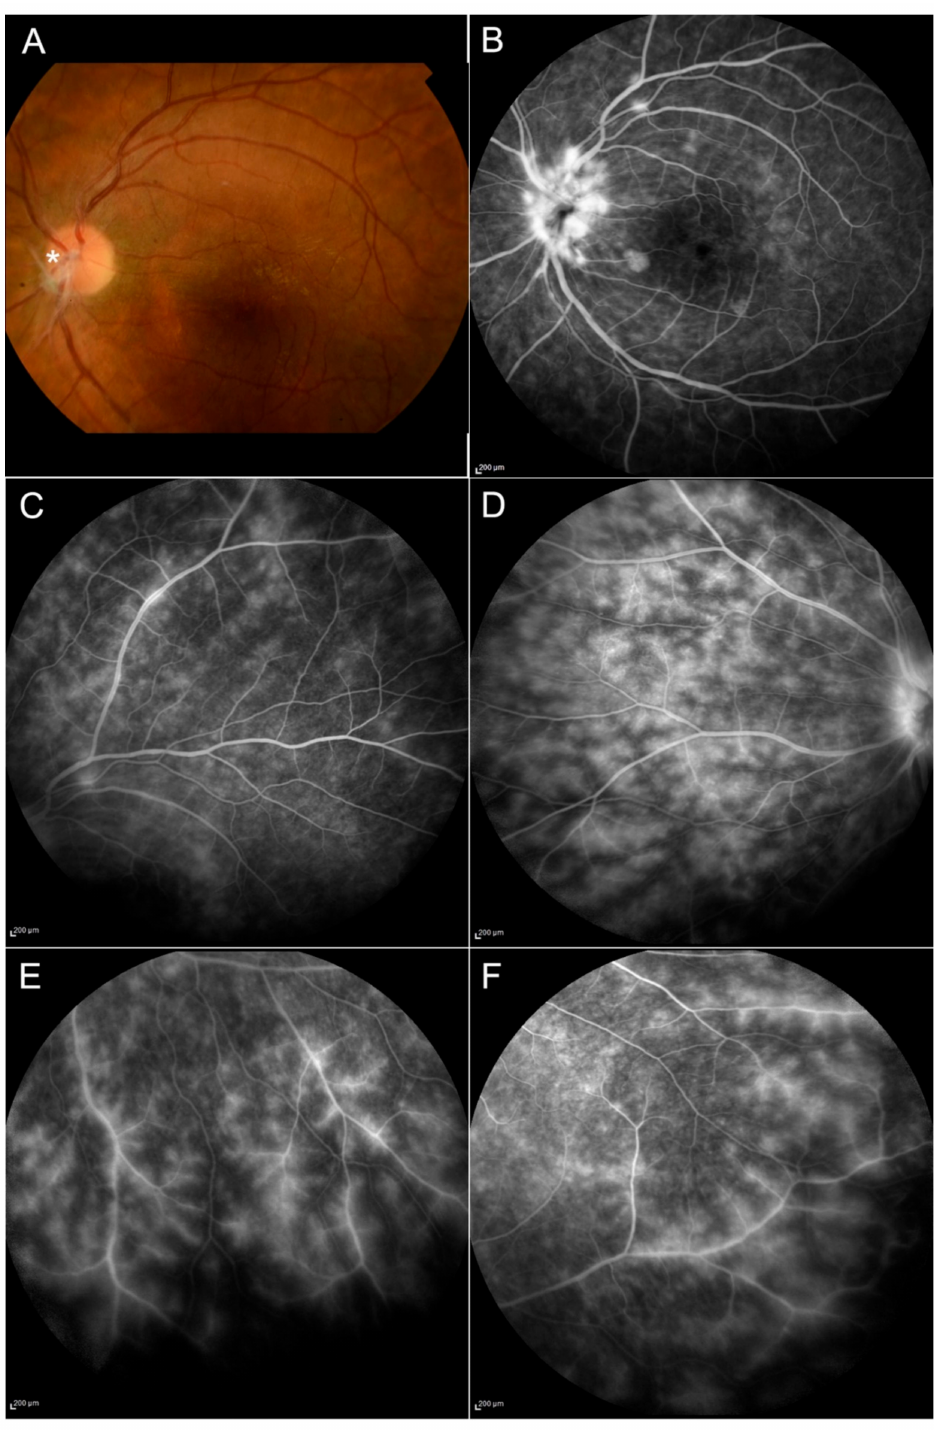
Figure 2. Behçet disease. Signs of active vasculitis can be seen in the posterior pole ( A , B ) and in the peripheral retina ( C – F ) with the presence of ischemic areas; papillitis is shown in ( B ). The fundus image displays the presence of hyalinized retinal vessels ( asterisk ) and an epiretinal membrane on the macula ( A